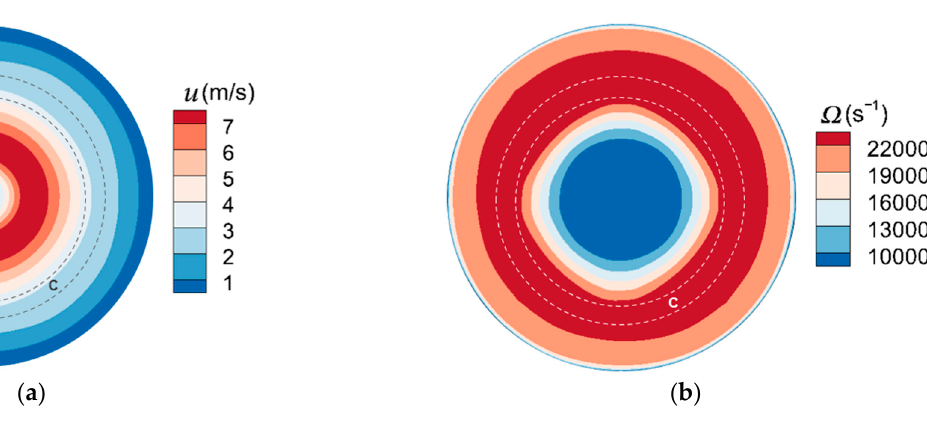
Figure 8. The ( a ) fluid velocity distribution and ( b ) vorticity above the plate for Re = 700, stk = 0.25. Region C represents the ring deposit.